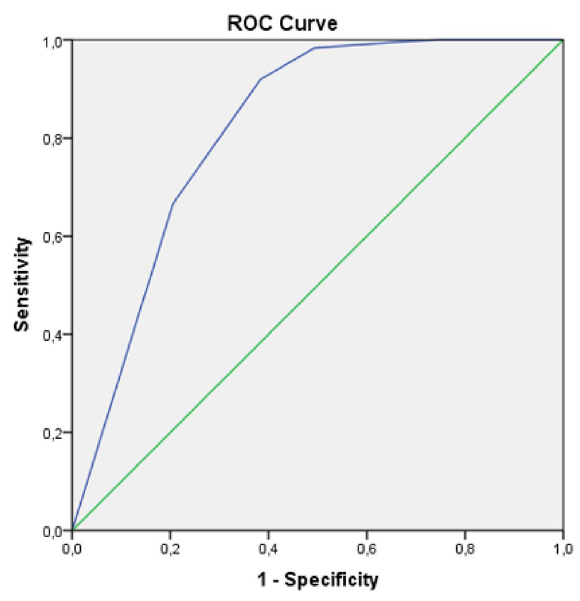
Fig. 1 – Receiver Operating Characteristics curve for the Brazilian version of the FiRST